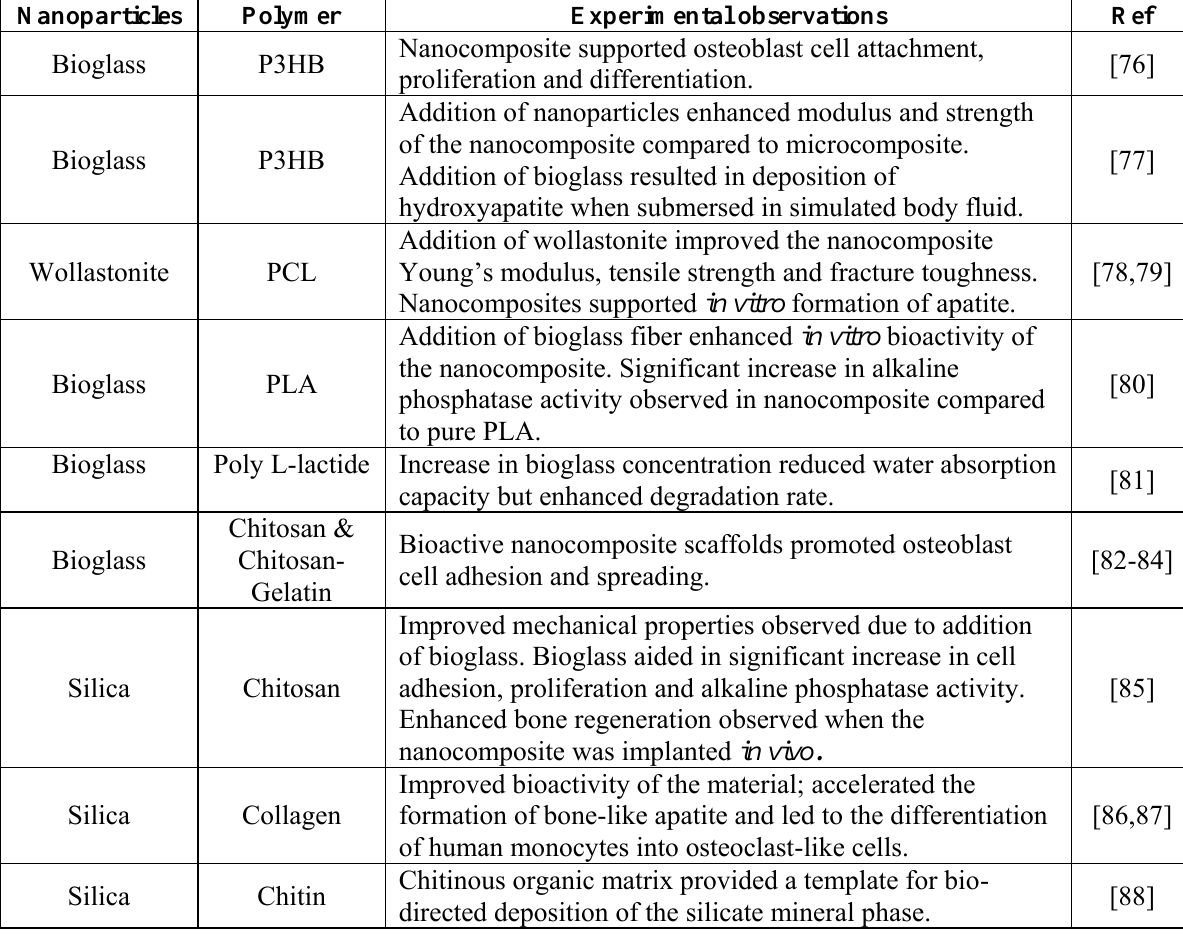
Table 4. Polymer-bioactive glass